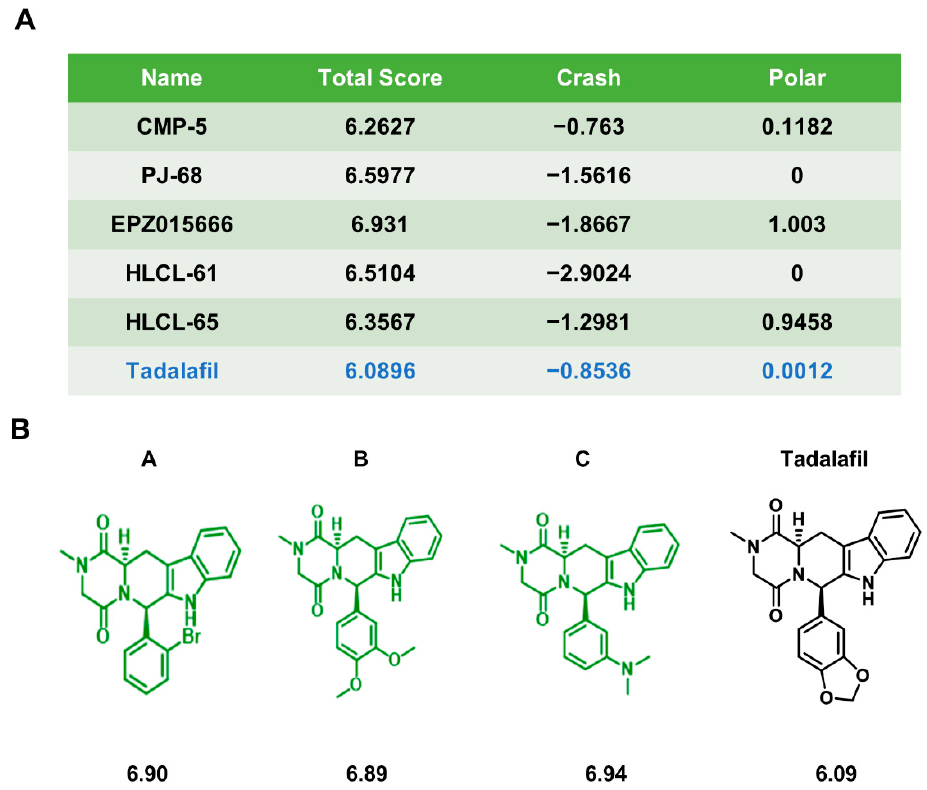
Figure 1. Chemical synthesis of chemicals A, B, and C. ( A ) Molecular docking scores of tadalafil and some existing PRMT5 inhibitors with PRMT5. ( B ) Chemical structures and molecular docking scores of chemicals A, B, C, and tadalafil.